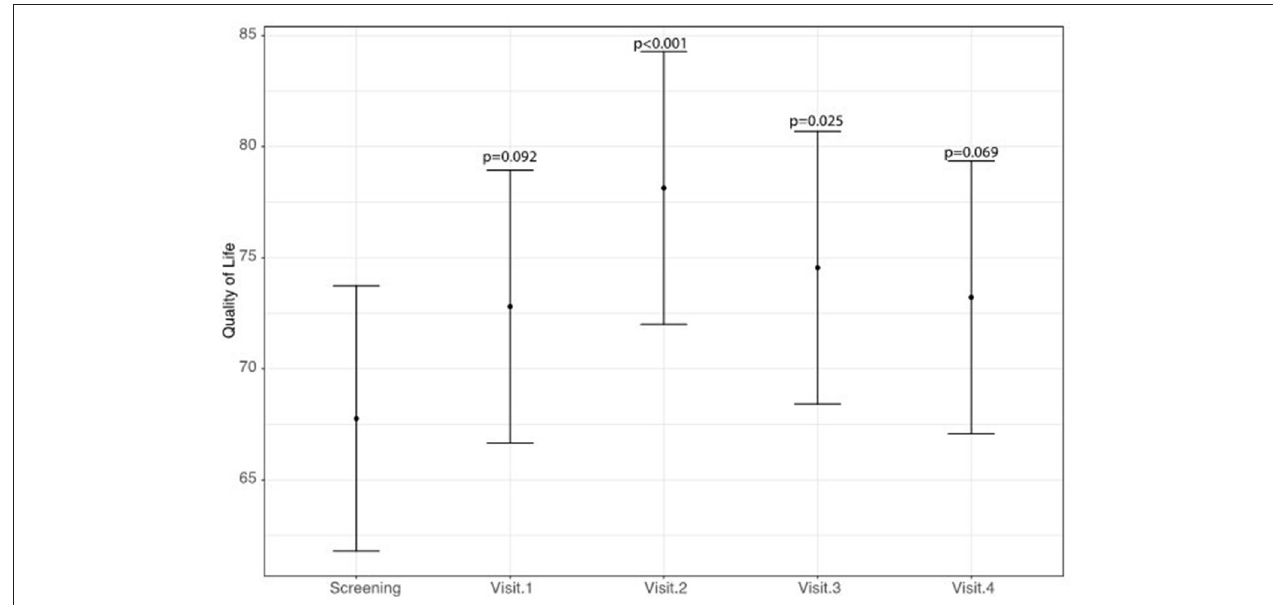
FIGURE 2 | Variation of quality of life levels (higher scores indicate improved quality of life).